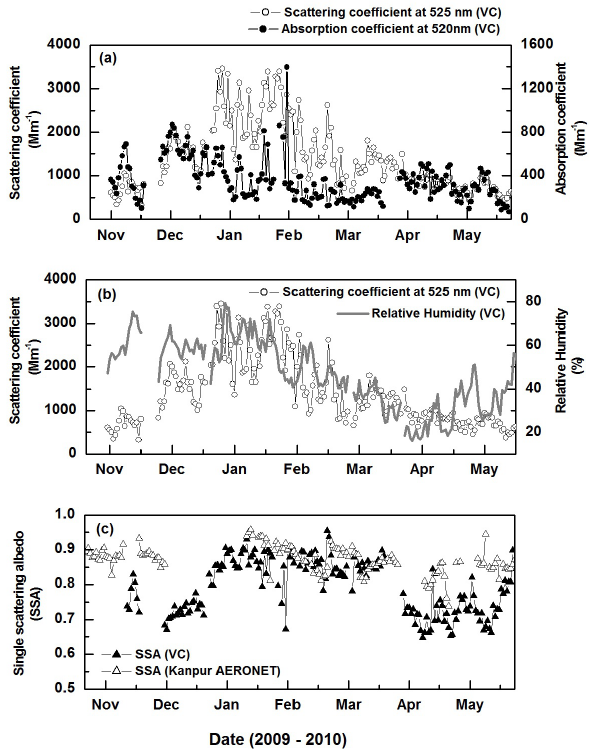
Fig. 7. (a) Daily variation of aerosol absorption coefficient and scat- tering coefficient from surface observation at SVI 1 village center (VC), (b) daily variation of scattering coefficient and relative hu- midity (RH) from surface observation at SVI 1 village center (VC), (c) daily variation of single scattering albedo (SSA) at SVI 1 vil- lage center (VC) and column measured SSA from AERONET site located in neighbouring urban centre, Kanpur.